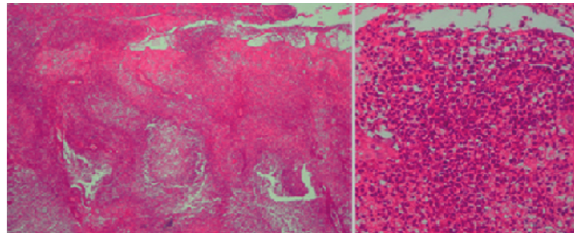
Figure3:Histopathologicalinjuryevaluationbyhematoxylin-eosin stain. Necrosis of the epidermis and predominantly neutrophilic inflammatory infiltrate in the dermis.